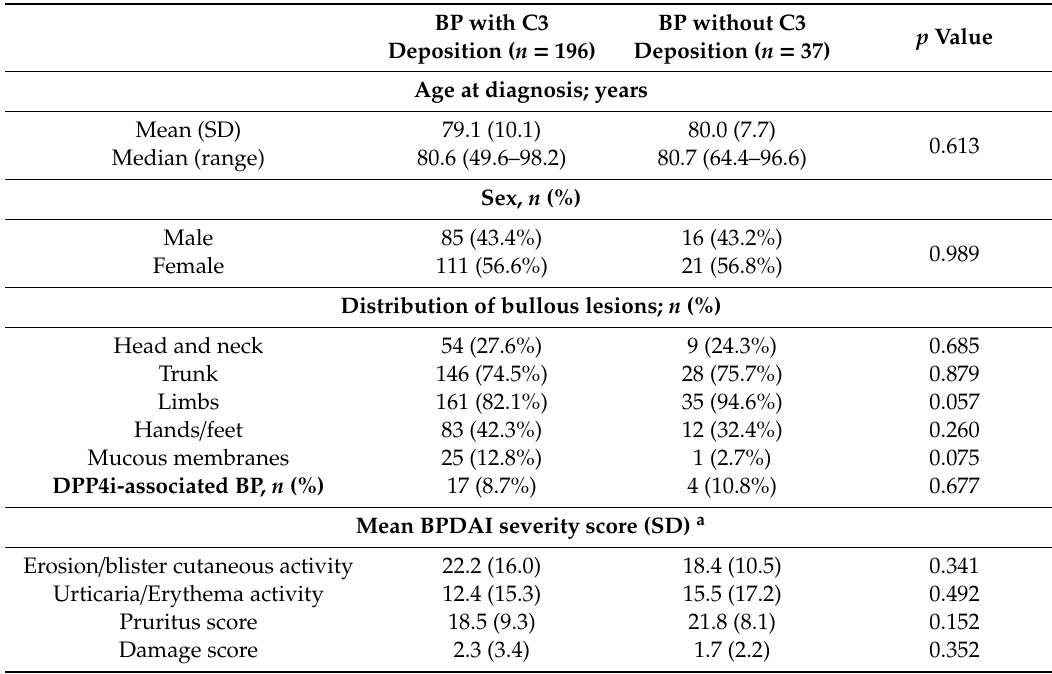
Table 1. Demographic and clinical characteristics of BP patients with C3 deposition by DIF as compared to BP patients without C3 deposition.